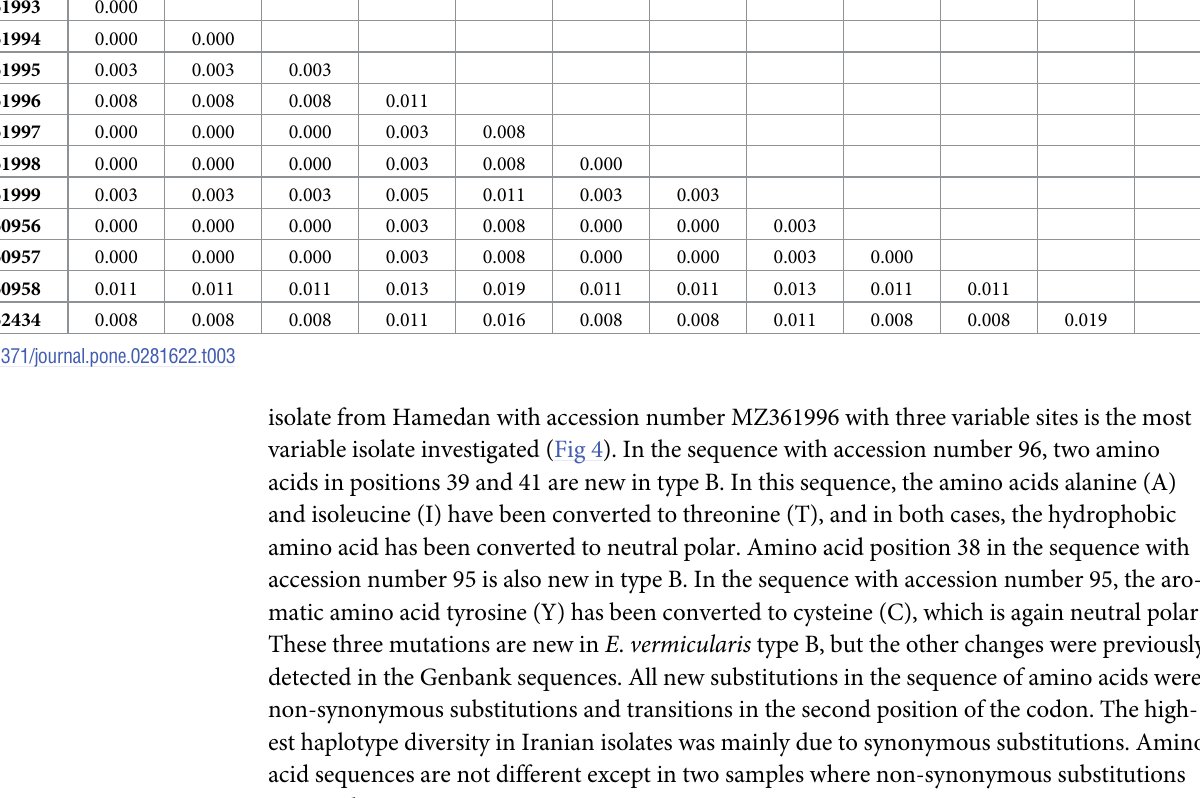
PLOS ONE | https://doi.org/10.1371/journal.pone.0281622 February 9,